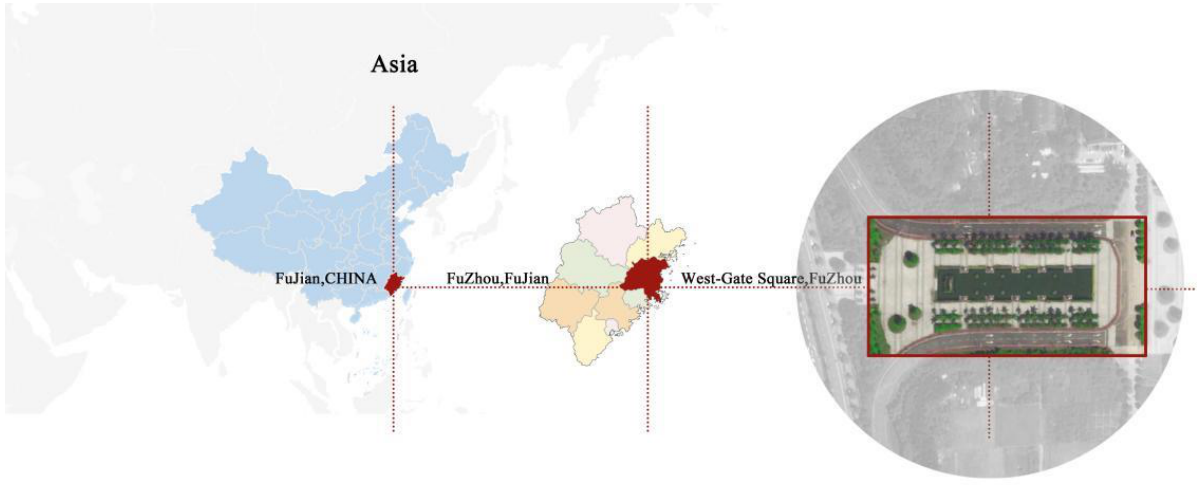
Figure 1. Location map of the study area.